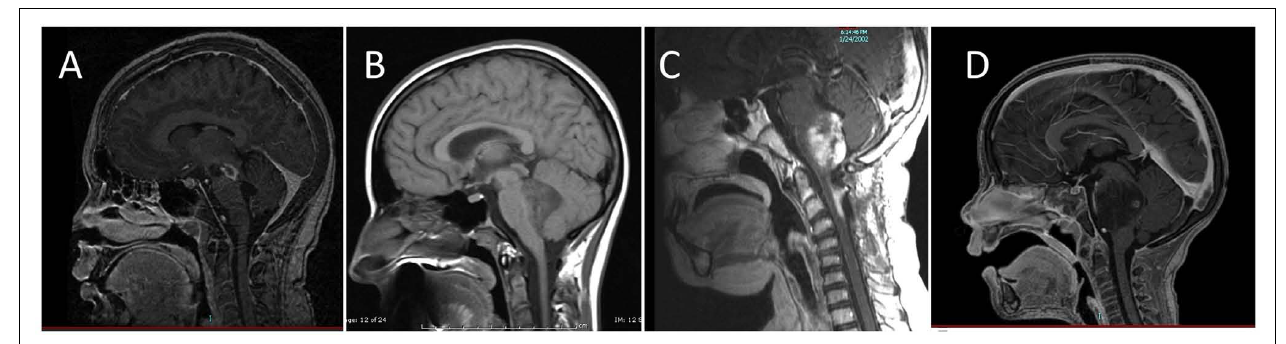
FIGURE 1 | Classification of brainstem gliomas by MRI appearance. (A) Focal brainstem lesion onT1-weighted post-contrast sagittal image. (B) Dorsal exophytic brainstem lesion on sagittal non-contrast MRI. (C) Cervicomedullary lesion onT1-weighted post-contrast sagittal image. (D) Diffuse intrinsic pontine glioma lesion onT1-weighted post-contrast sagittal image.